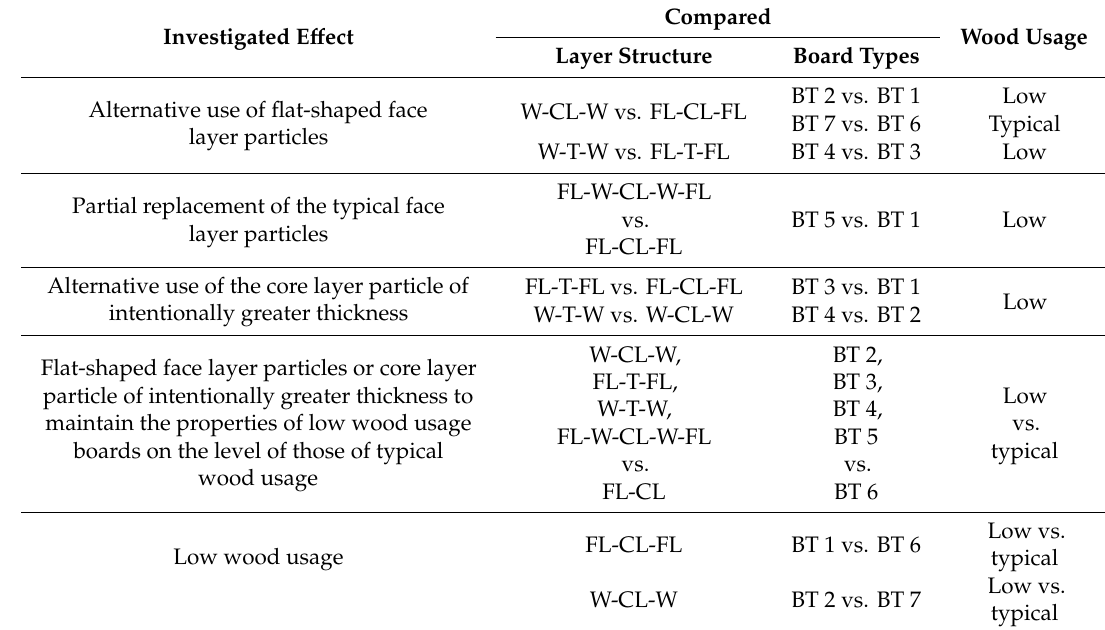
Table 3. Overview of the comparisons made to determine the e ff ect of particle